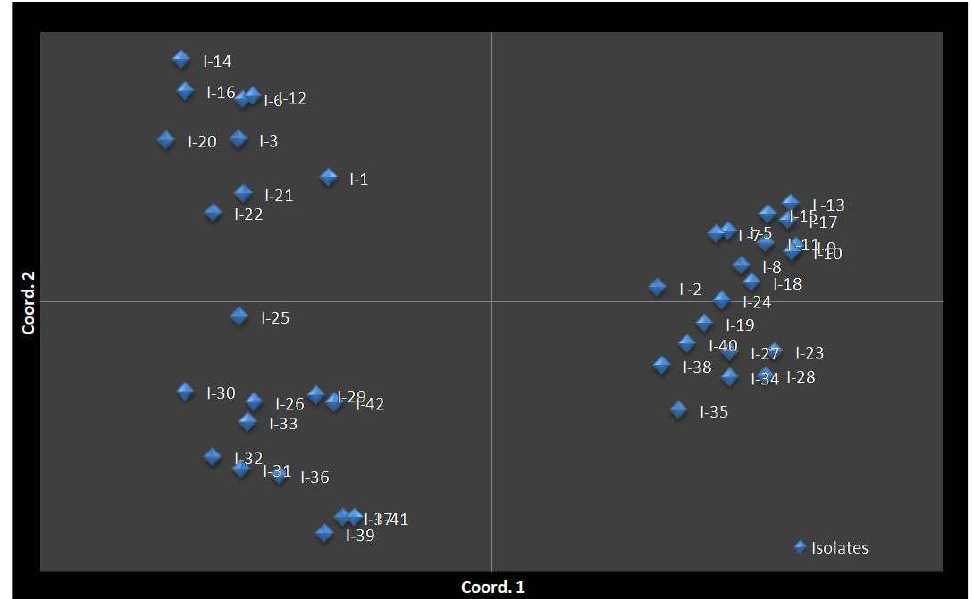
Figure 9. Two-dimensional principal coordinate analysis (PCoA) showing the pattern of sub-clustering of 41 isolates of C. falcatum isolates from four regions of Bangladesh.